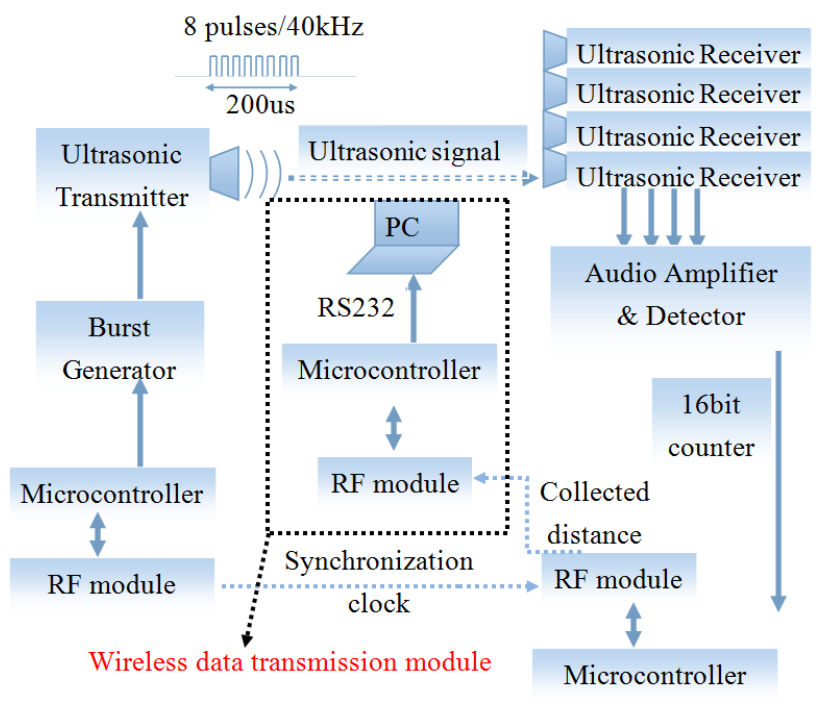
Figure 1. General configuration of the